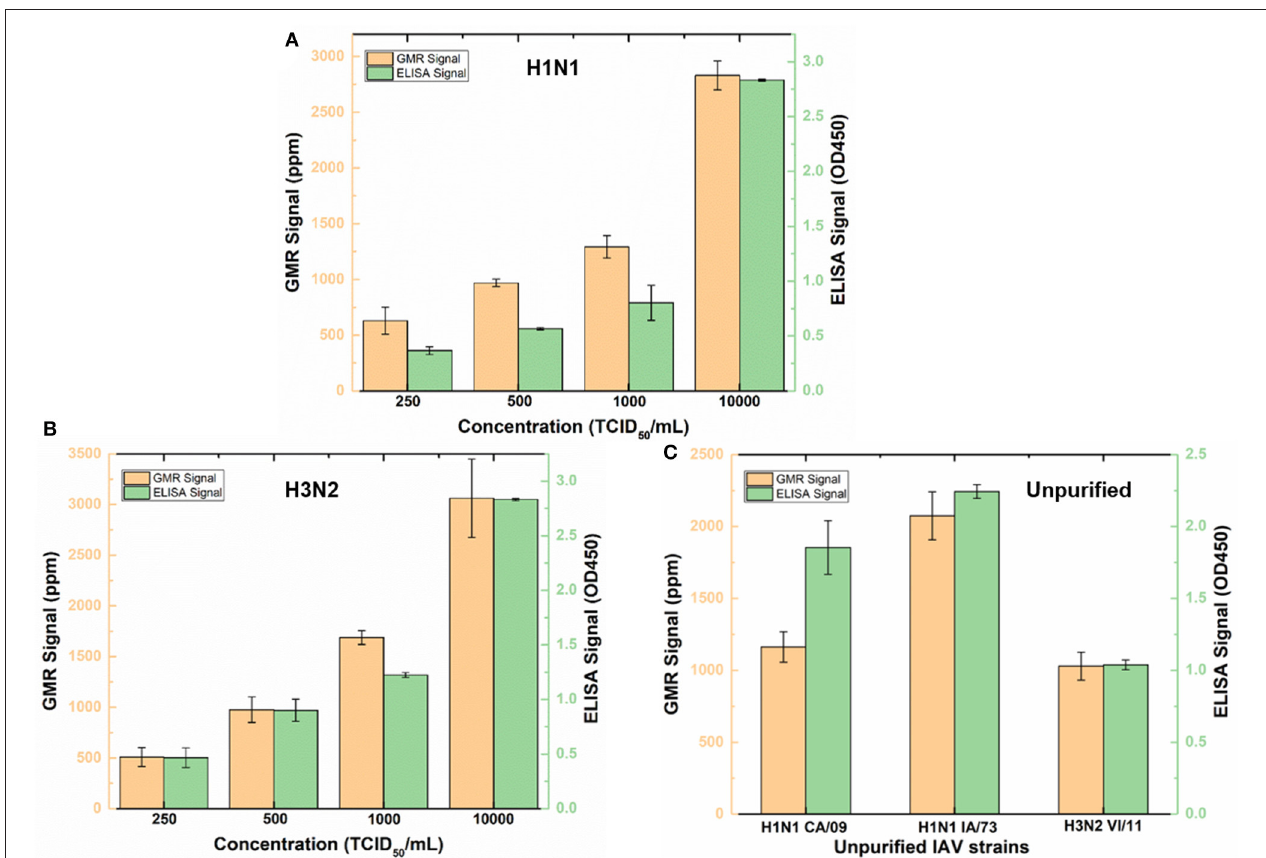
FIGURE 4 | Z-lab and ELISA results for nasal swab samples spiked with 250, 500, 1,000, and 10,000 TCID 50 /mL of H1N1 CA/09 (A) and H3N2v (B) virus, and different IAV strains (C) . The error bars indicate the standard deviation of the signal from GMR sensors on the chip as well as from ELISA measurements.